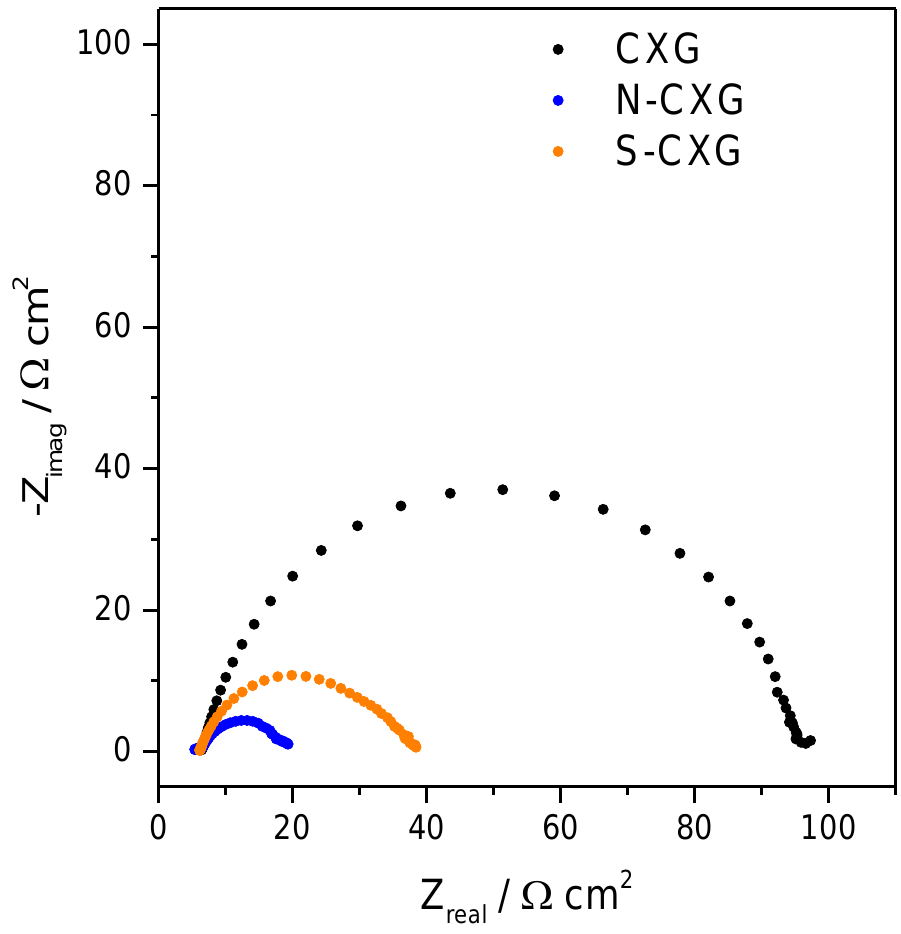
Figure 5. Impedance spectra at OCP for bare and doped carbon xerogels as counter electrode.